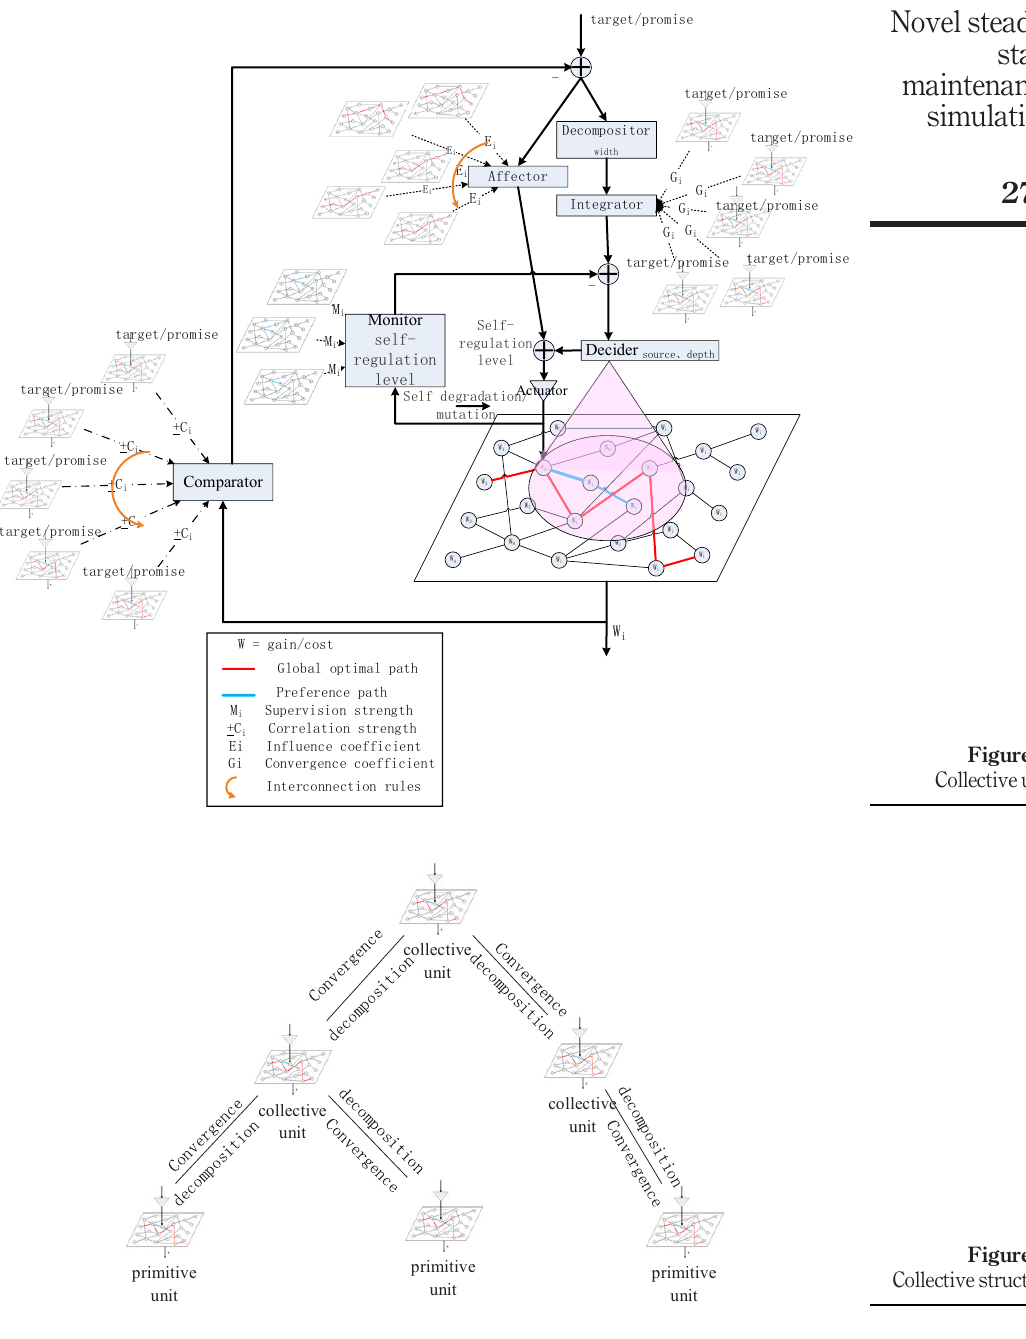
Figure 2. Collective